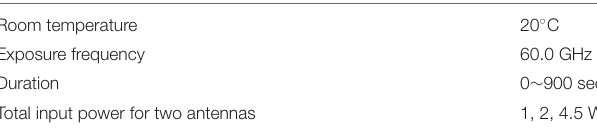
TABLE 3 | Experimental conditions for measuring temperature elevations in